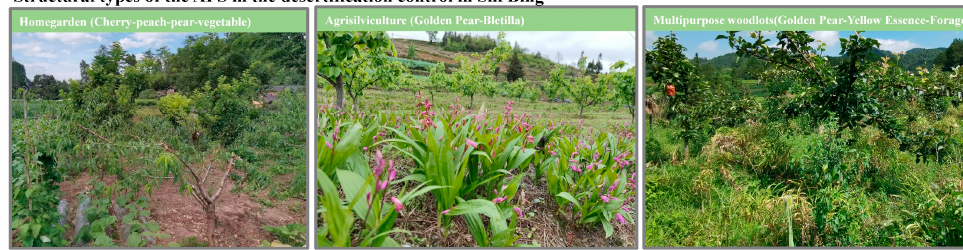
Figure 4. Schematic diagram of three types of AFS used in the control of KD.